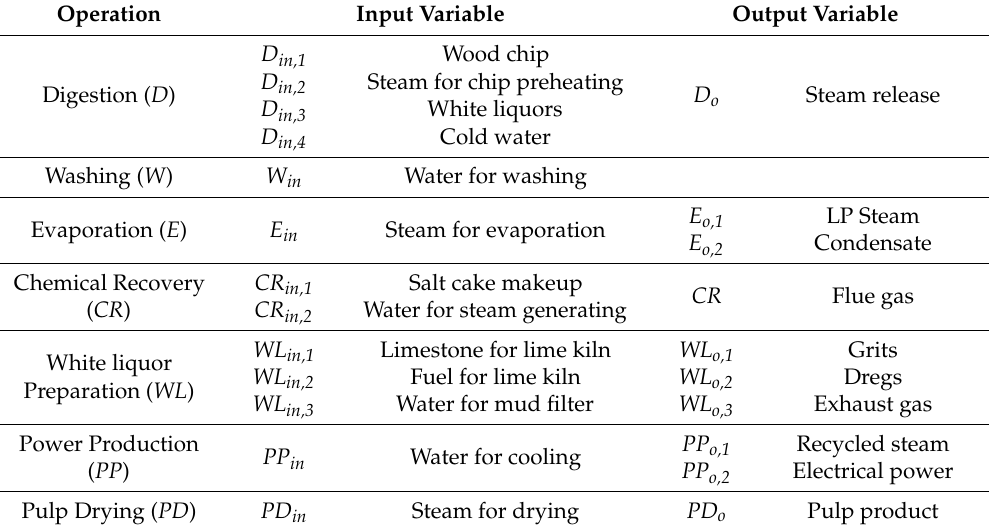
Table 1. Input and output variables for modeling of pulp